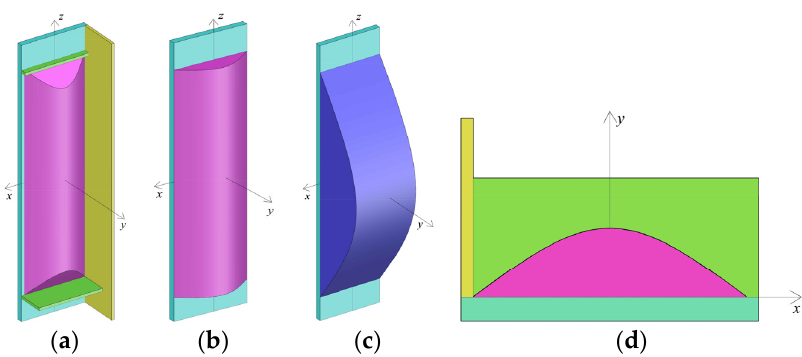
Figure 11. Schematic diagram of 3D boundary of inactive and active cofined concrete. ( a ) Isolated body; ( b ) Transverse boundary; ( c ) Lateral boundary; ( d ) Plane graph.